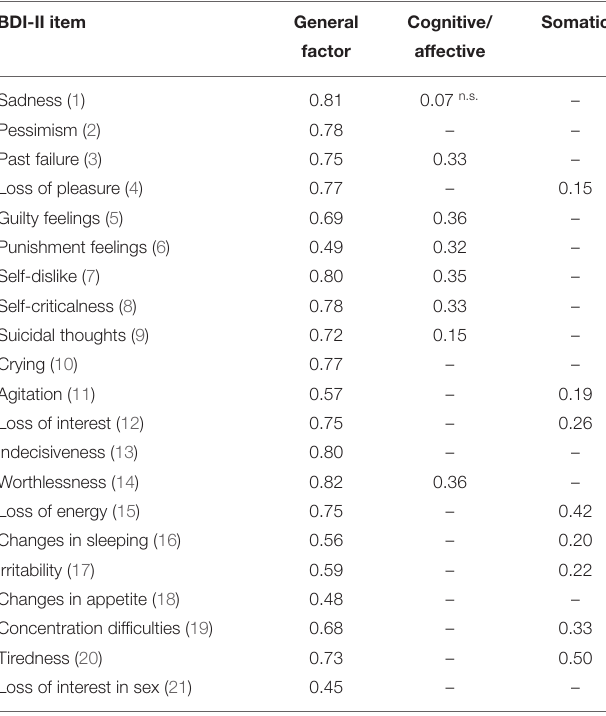
TABLE 5 | Factor loadings for the confirmatory bifactor solution for the total sample ( n = 835). BDI-II